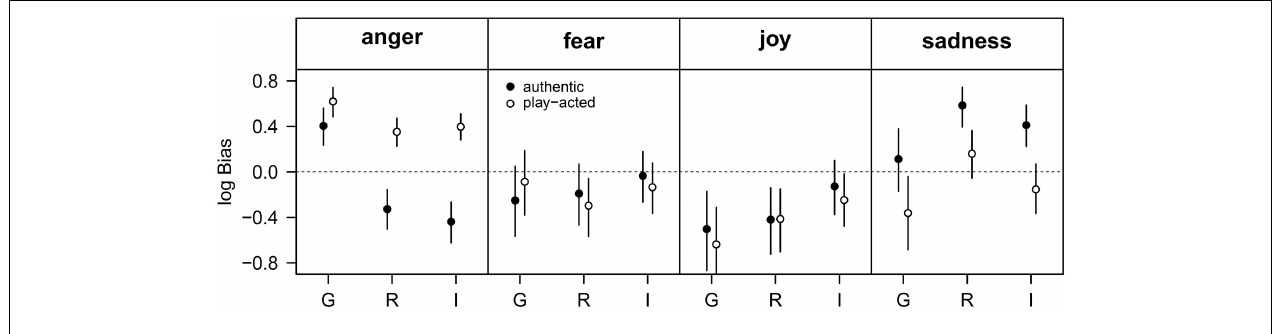
given as means and 95% uncertainty interval. In the absence of any bias, all four log-transformed bias values would be zero. Positive values indicate a bias toward choosing the response named in the headline, whereas a value below zero indicates a bias against choosing the respective response.